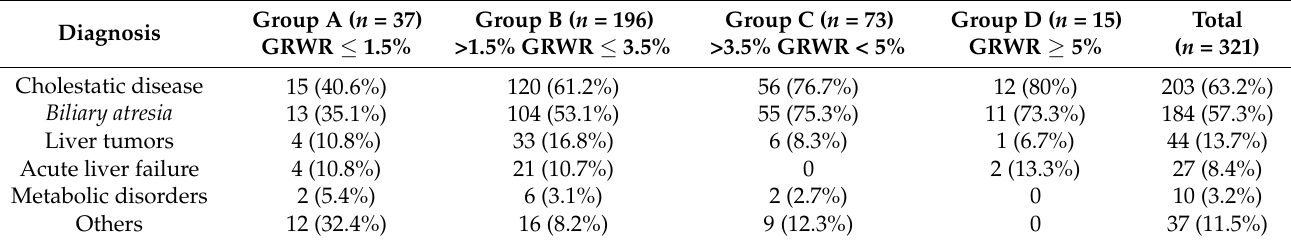
Table 2. Underlying liver disease of